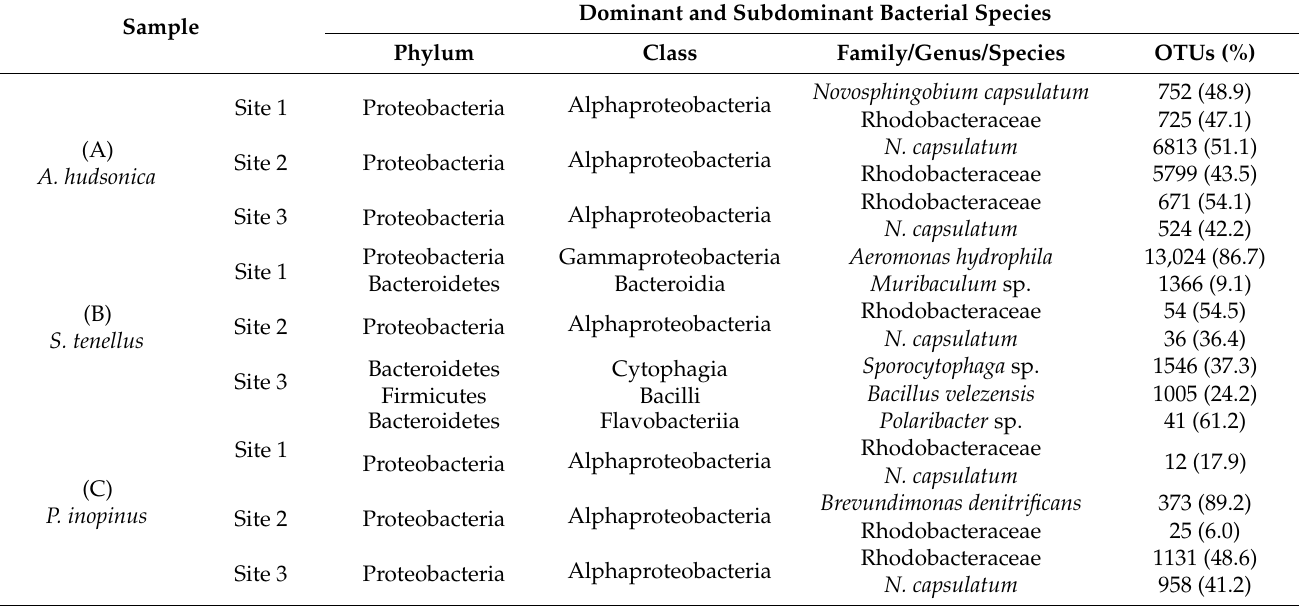
Table 2. Dominant and subdominant species of copepod gut bacterial communities based on the proportion of